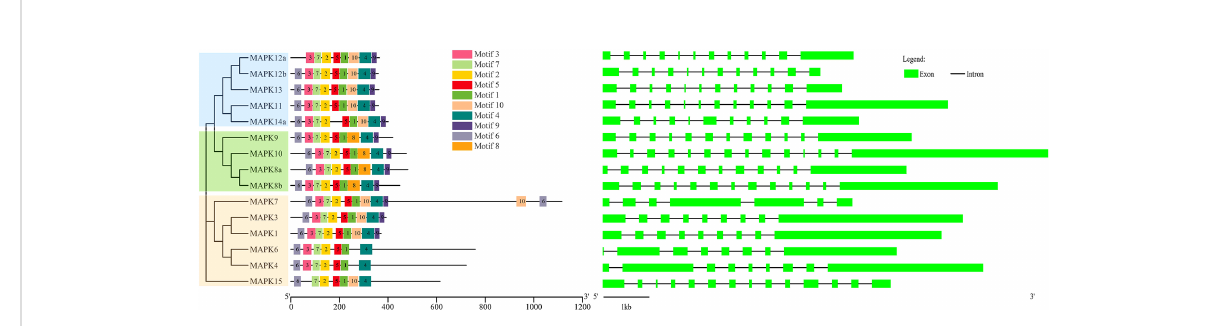
FIGURE 3 The combination of phylogenetic relationship, conserved motif, and exon – intron structure. The left of the graph shows the phylogenetic relationships. The middle of the graph shows the distribution of conserved motifs, and each colored rectangular box represents a motif. The right of the graph shows the exon – intron structure, and the lengths of introns in each Sm MAPK are displayed in the same